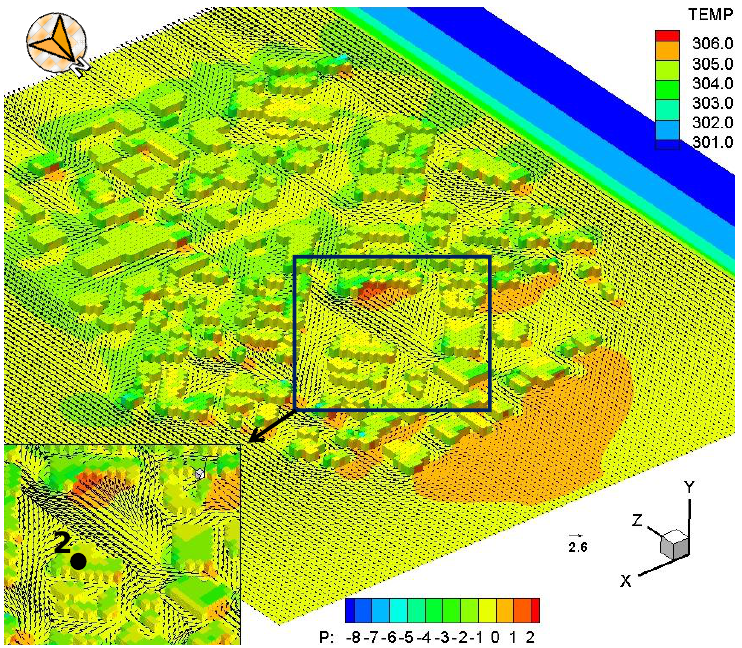
Figure 13. Contours of constant pressure (in Pa on XZ ground plane and building surfaces) and contours of constant temperature (in K on YZ plane). Insert is the region around the building where wind speed measurements were performed (point 2 in Figure 1). Atmospheric conditions corresponding to Pasquil B category (Table 1).